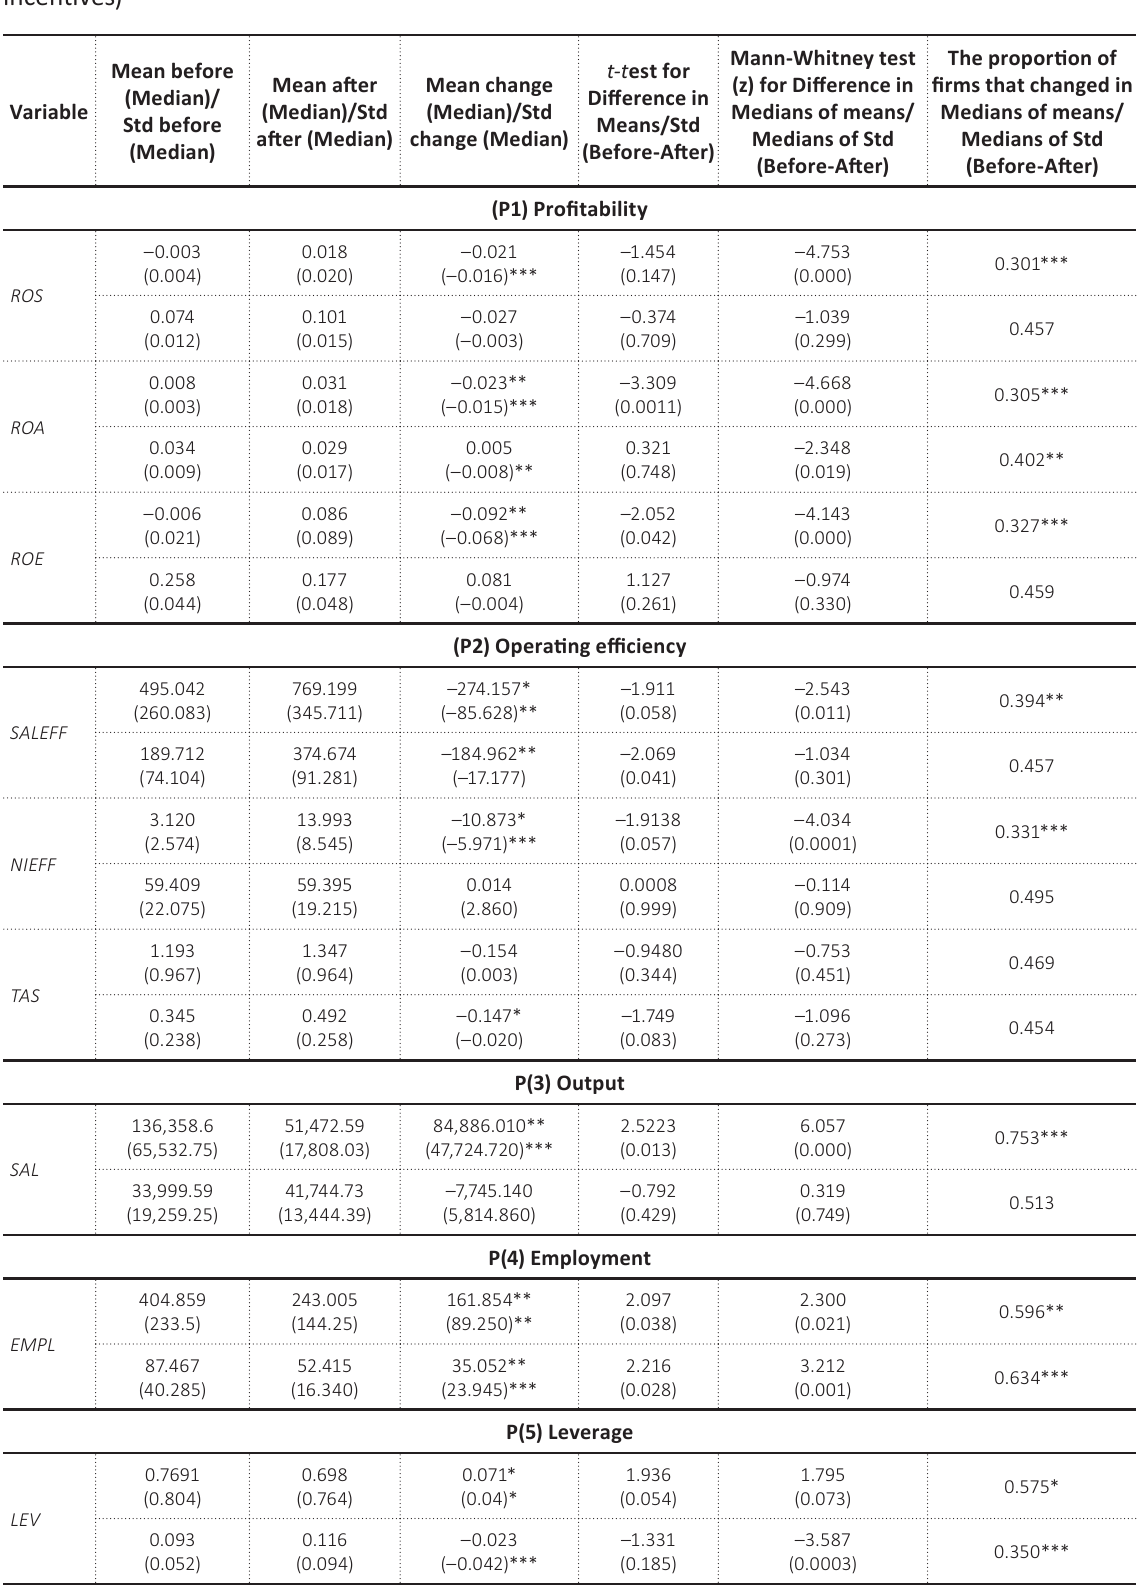
Table A4. Performance changes of unlisted SOEs after privatization (privatized SOEs with tax